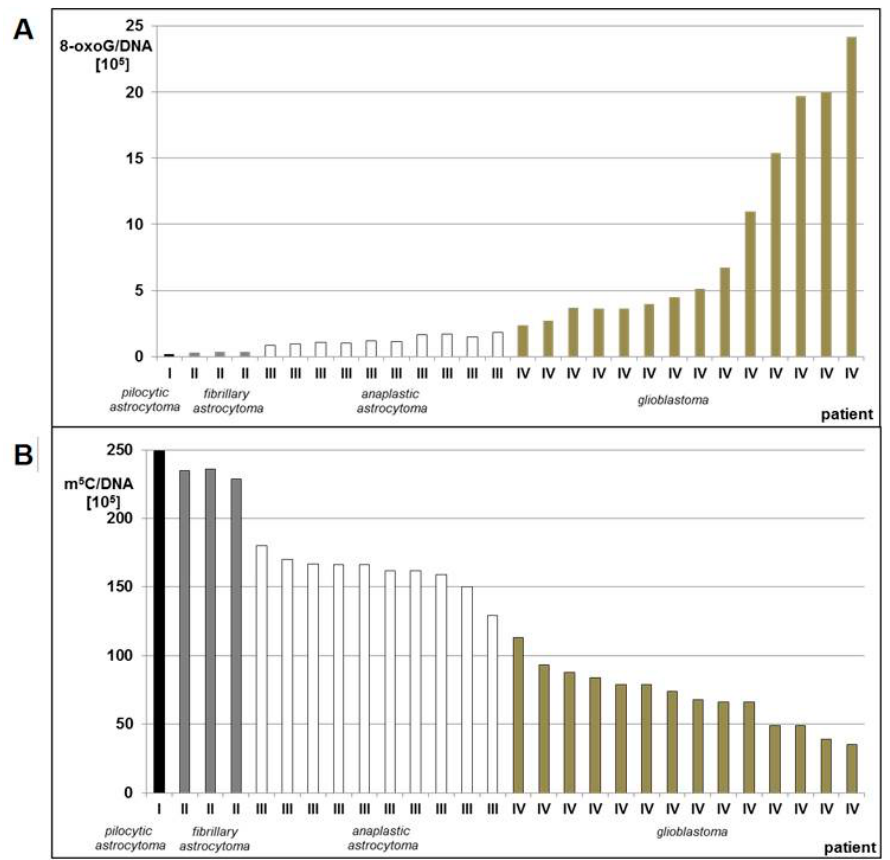
Figure 2. 8-oxo-dG ( A ) and m 5 C ( B ) contents in DNA from human brain tumors tissues classified as pilocytic astrocytoma (WHO I), fibrillary astrocytoma (WHO II), anaplastic astrocytoma (WHO III), and glioblastoma (WHO IV).